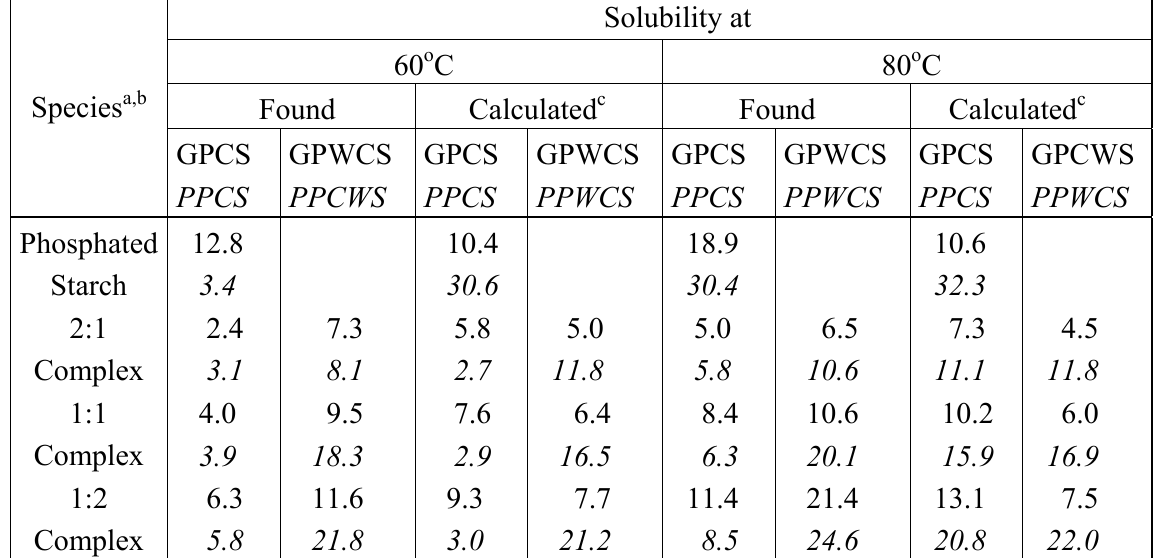
O] at 60 o C and 80 o C. 2 Solubility at